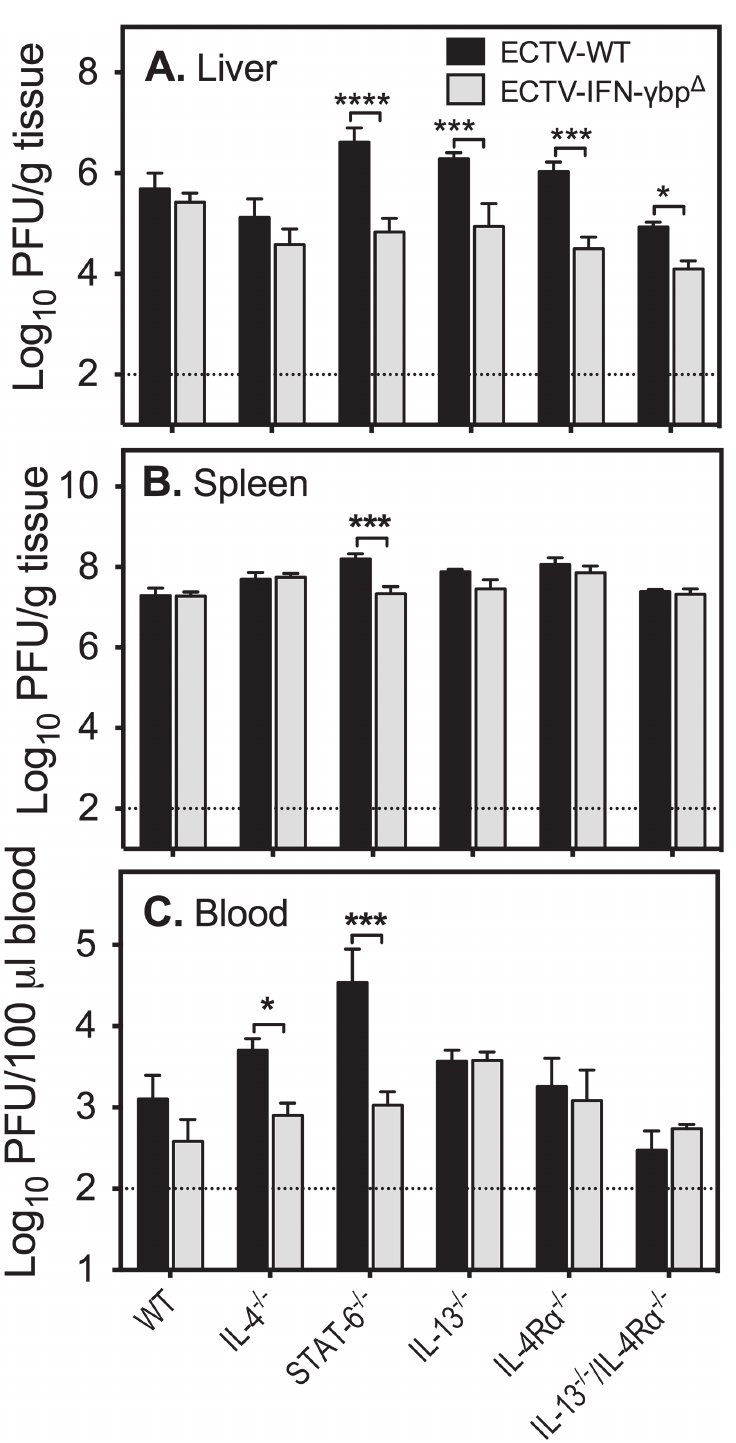
Fig 2. Viral load in organs and blood of WT and GKO mice infected with ECTV-WT or ECTV-IFN- γ bp Δ . Groups of 5 mice were infected with either ECTV-WT or ECTV-IFN- γ bp Δ and sacrificed at day 7 p.i. Viral load was determined by viral plaque assay and expressed as Log 10 PFU virus/gram tissue. The dotted line indicates the limit of virus detection by viral plaque assay. Two-way ANOVA followed by Fisher ’ s LSD test for significance between (i) ECTV-WT titers in WT mice compared with all strains, (ii) ECTV-IFN- γ bp Δ load in WT mice compared with all strains, and (iii) ECTV-WT compared with ECTV-IFN- γ bp Δ load in individual